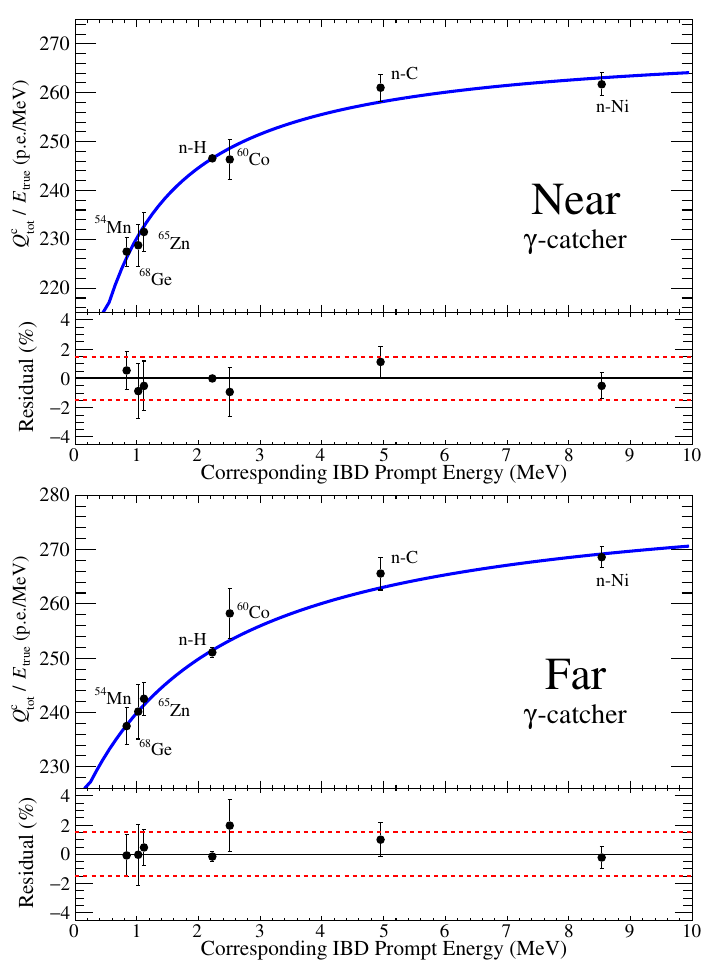
Figure 6 . Energy conversion for the IBD prompt signal observed in the GC regions of the near and far detectors. It is obtained from the visible energies of (cid:13) -rays coming from various radioactive sources and n-H delayed signal. The curves are the best (cid:12)ts to the data points using a non-linear function. The lower panels show the fractional residuals of calibration data points with respect to the best